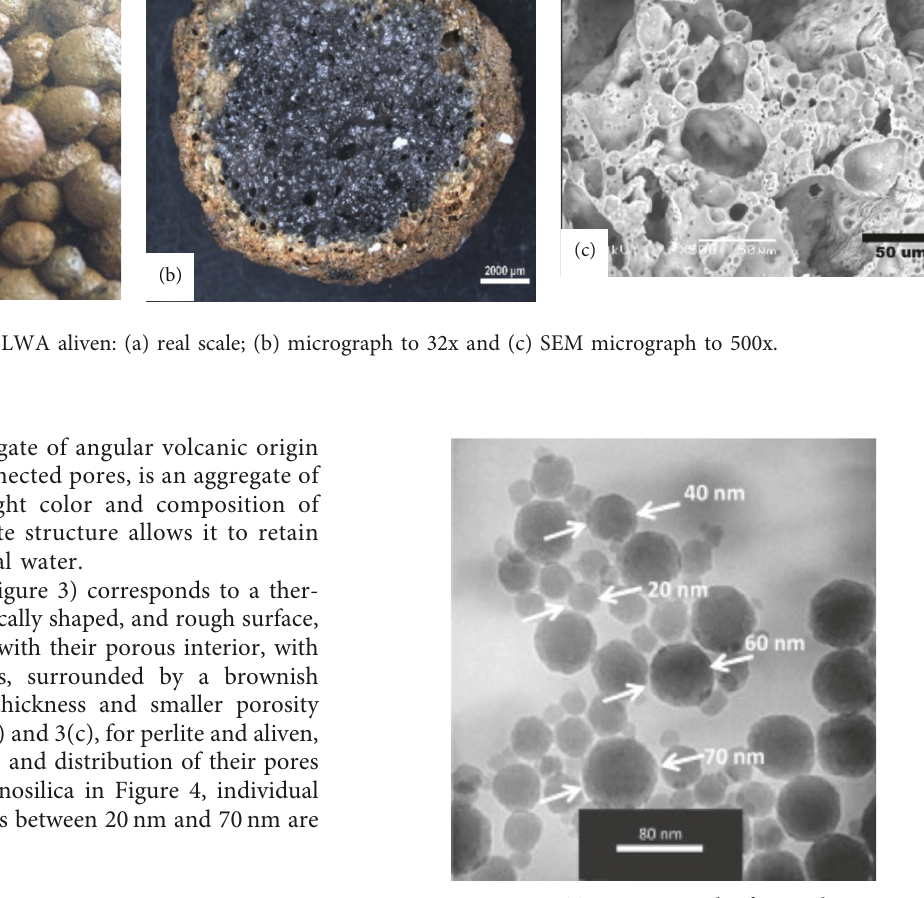
Figure 4: TEM micrograph of